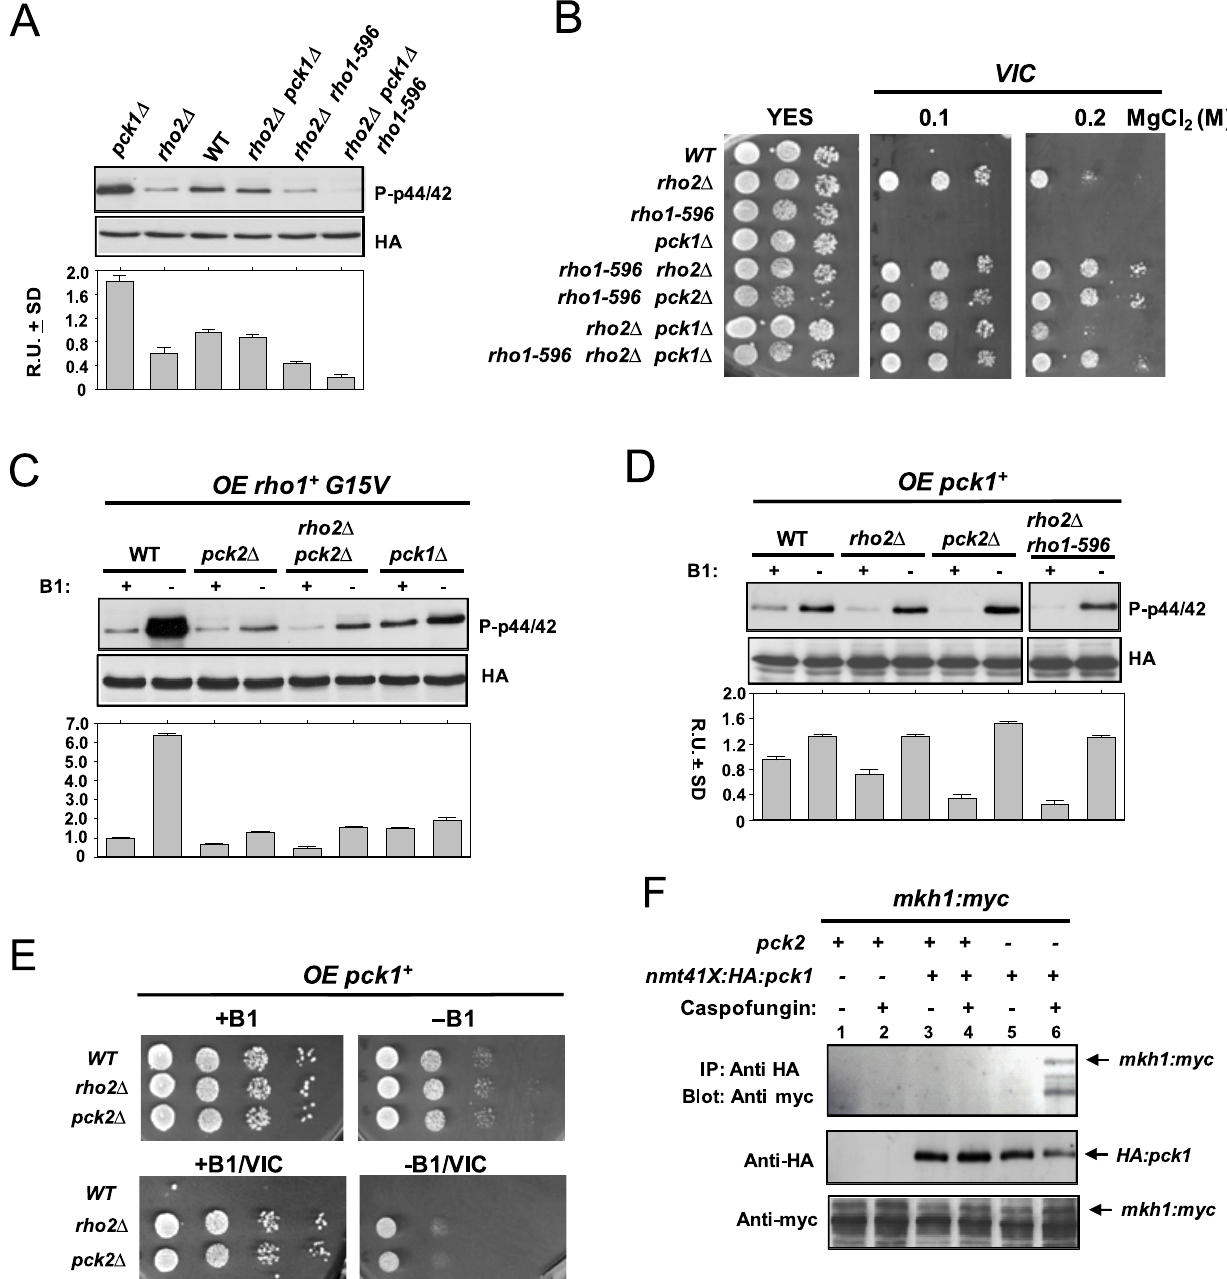
Figure 3. Pck1 is a positive regulator of the cell integrity MAPK pathway. (A) Strains MI200 (WT), MI700 ( rho2 D ), GB35 ( pck1 D ), LS206 ( rho2 D pck1 D pmk1-HA6H ), LS202 ( rho1-596 rho2 D pmk1-HA6H ), and LS208 ( rho1-596 rho2 D pck1 D pmk1-HA6H ) were grown in YES medium to mid log-phase. Pmk1-HA6H was purified and both activated and total Pmk1 were detected by immunoblotting with anti-phospho-p42/44 and anti-HA antibodies, respectively. (B) VIC assays for strains MI200 (WT), MI700 ( rho2 D ), LS201 ( rho1-596 ), GB35 ( pck1 D ), LS202 ( rho1-596 rho2 D ), LS203 ( rho1-596 pck2 D ), LS206 ( rho2 D pck1 D ), and LS208 ( rho1-596 rho2 D pck1 D ). After growth in YES medium, 10 4 , 10 3 or 10 2 cells were spotted onto YES plates supplemented with 0.5 m g/ml FK506 plus 0.1 or 0.2 M MgCl 2 , and incubated for 3 days at 28 u C before being photographed. (C) Strains MI200 (WT), GB3 ( pck2 D ), GB29 ( rho2 D pck2 D ), and GB35 ( pck1 D ) were separately transformed with pREP3X- rho1 + (G15V) plasmid and grown for 18 h in the presence ( + B1) or absence ( 2 B1) of thiamine. Pmk1-HA6H was purified and the activated and total Pmk1 was detected as indicated above. (D) Strains MI200 (Control), MI700 ( rho2 D ), GB3 ( pck2 D ), and LS202 ( Rho1-596 rho2 D ) were separately transformed with pREP3X- pck1 + plasmid, grown for 24 h with or without thiamine, and both total and activated Pmk1 were detected as above. (E) Strains MI200 (WT), MI700 ( rho2 D ), and GB3 ( pck2 D ) transformed with pREP3X- pck1 + plasmid were grown in minimal medium, and10 4 , 10 3 , 10 2 or 10 1 cells were spotted onto EMM2 mediumwith or without 5 m g/ml thiamine in the presence/absence of 0.5 m g/ml FK506 plus 0.2 M MgCl 2 ( VIC ). Theplateswere incubated for3 days at 28 u C before beingphotographed.(F) Strains LS210 ( mkh1-13myc ; lanes 1 and 2, negative controls), LS211 ( nmt41:HA-pck1 mkh1-13myc ; lanes 3 and 4), and LS212 ( nmt41:Ha-pck1 mkh1-13myc pck2 D ; lanes 5 and 6) were grown in EMM2 medium in the absence of thiamine for 24 h, and left untreated (uneven lanes), or supplemented with 1 m g/ml Caspofungin for 1 hour (even lanes). Cell extracts were immunoprecipitated (IP) with anti-Ha antibody (12CA5) and the immunocomplexes adsorbed with protein A-Sepharose. The complexes obtained were resolved by SDS-PAGE, and hybridized separately with anti-Ha and anti-myc antibodies. doi:10.1371/journal.pone.0088020.g003 PLOS ONE |